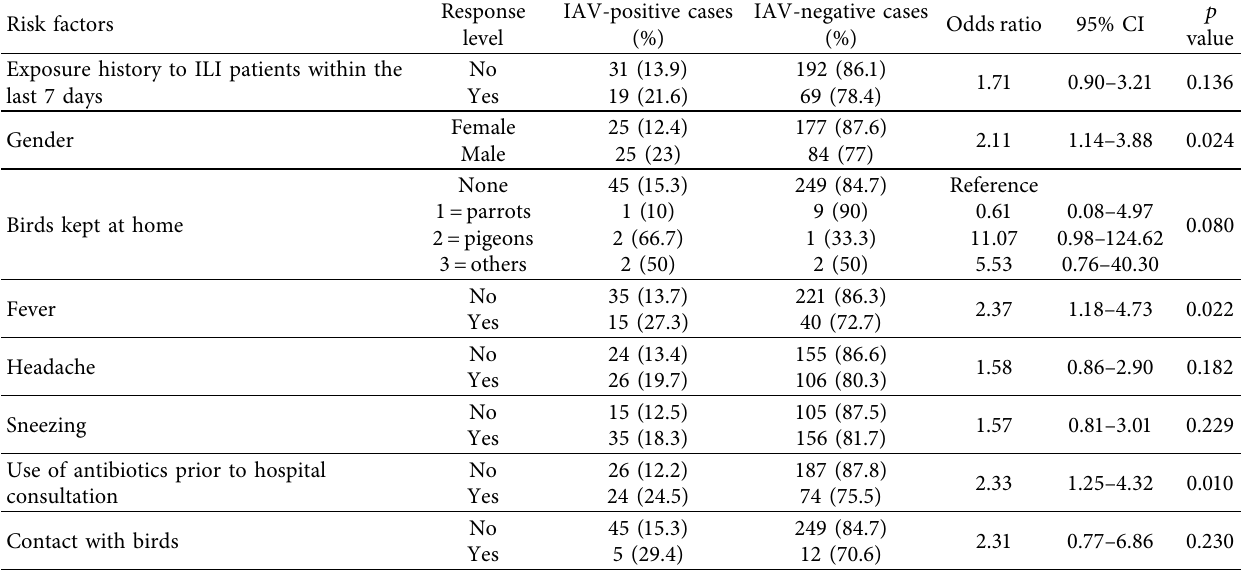
Table 1: Univariable analysis of potential risk factors/risk markers for IAV with p value ≤ 0.25 among ILI and SARI cases during hospital- based surveillance.